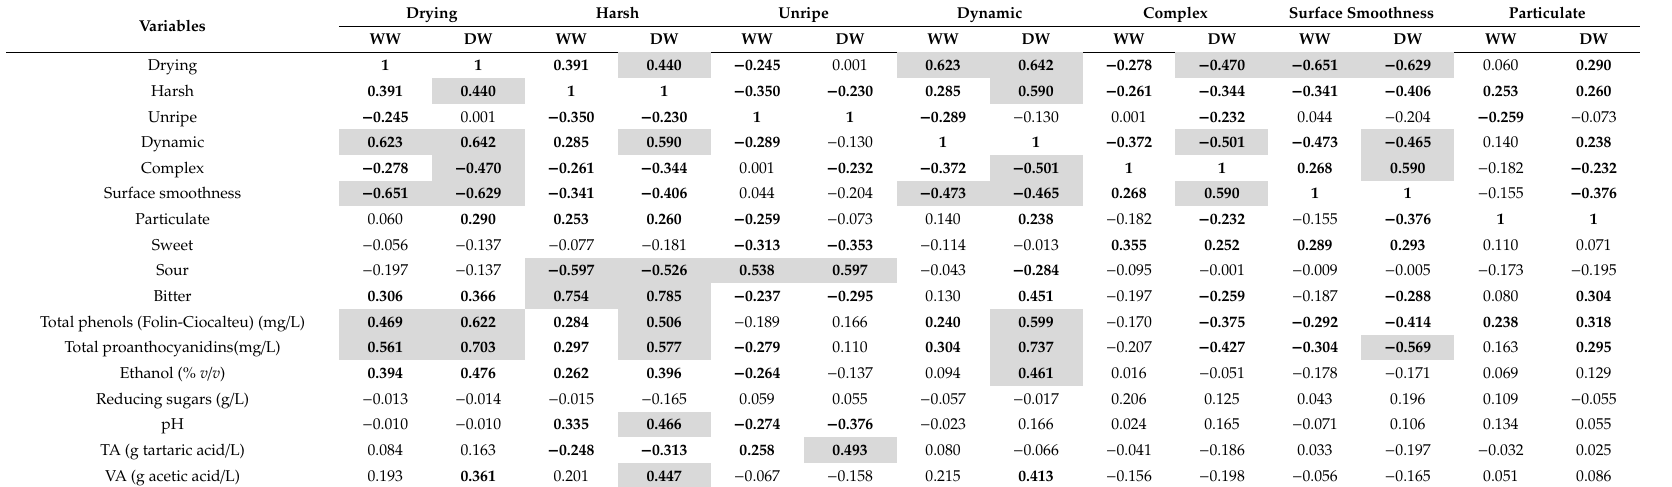
Table 5. Correlation coe ffi cients (Pearson) between astringency and chemical variables. Comparison between WW and DW.